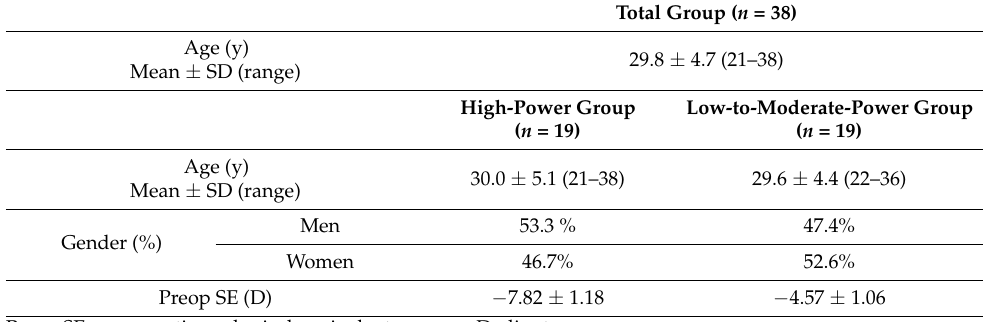
Table 1. Demographic